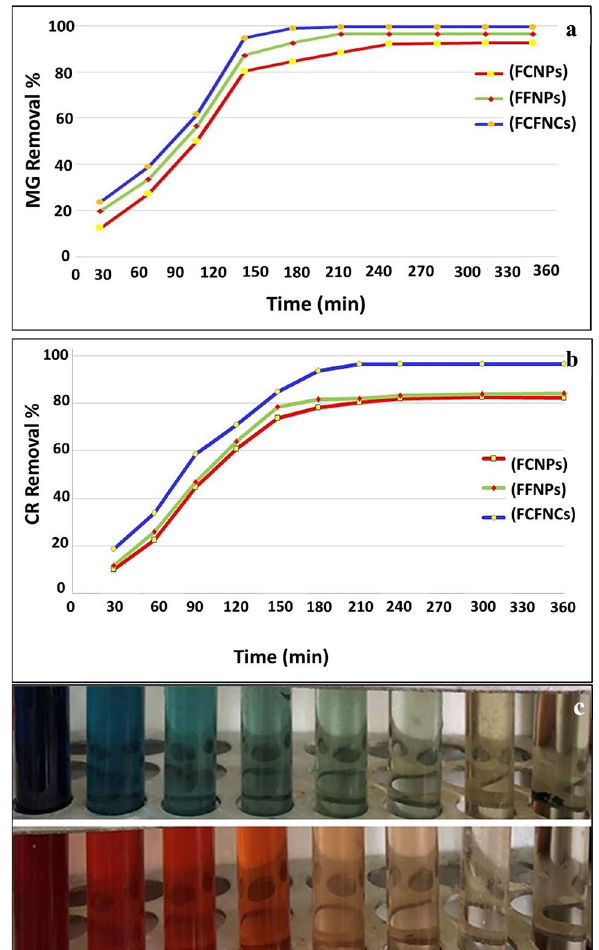
Figure 7. Contact time effect on removal of MG ( a ) and CR ( b ) using FCNPs, FFNPs and FCFNCs. Dye concentration (50 mg/L), NPs dose 1 g/L, temperature (30 °C), pH 7 and agitation speed (150 rpm); ( c ), photographic image showing MG and CR removal by FCFNCs with obvious color